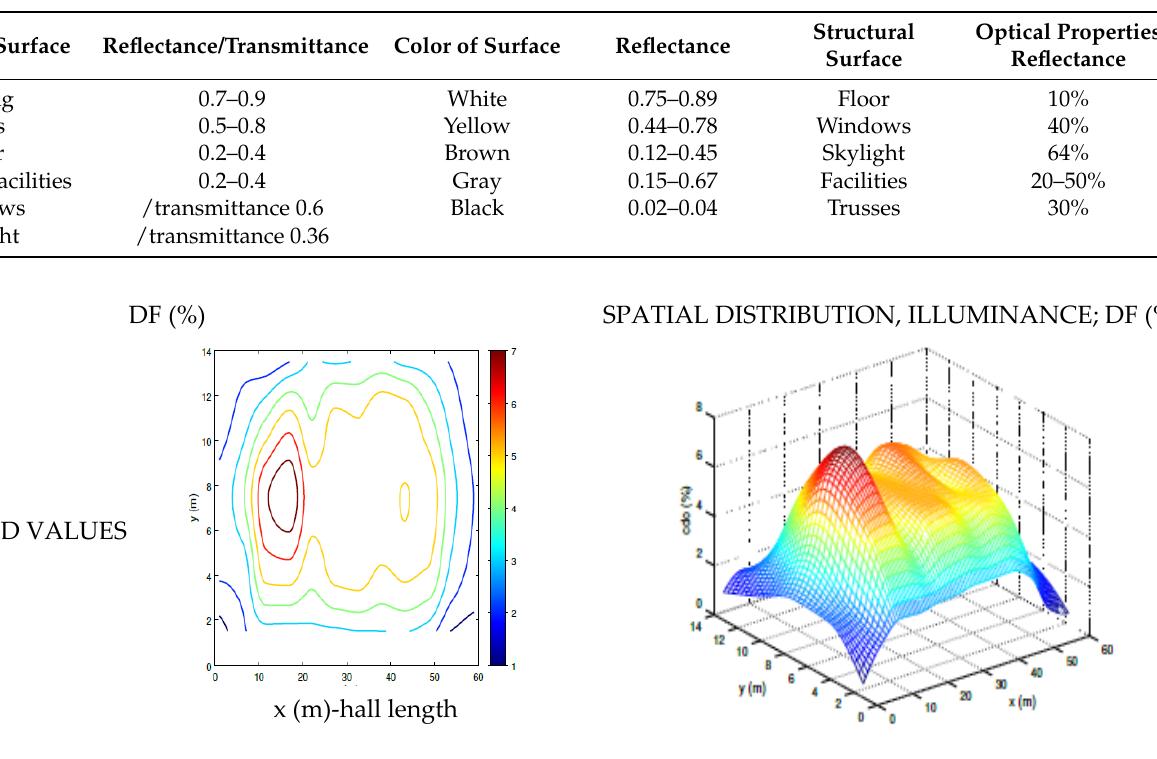
Table 2. Recommended reflection factor of surfaces, recommended reflection factor of colors, building material, and optical properties of the interior surfaces of the test hall.